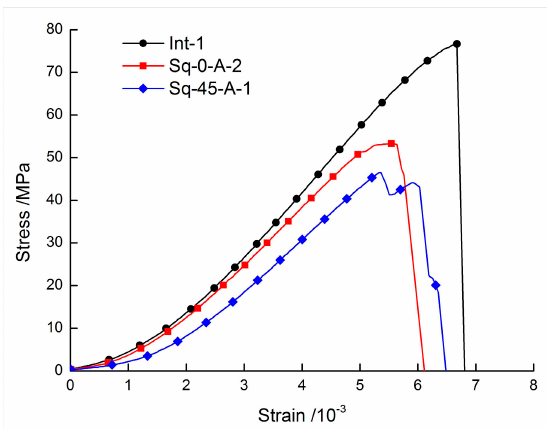
Figure 4. Typical stress–strain curves of intact specimen and specimens containing a square hole.